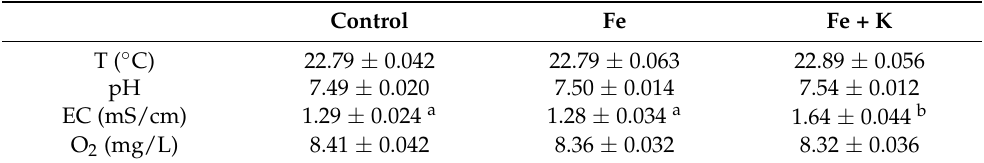
Table 1. Water physicochemical parameters in the fish tanks of the aquaponic systems during the study period (30 days) expressed as mean ± S.E.M. ( n = 75 for T, pH and n = 39 for EC, O 2 ). Means in a row followed by different superscript are significantly different ( p > 0.05).